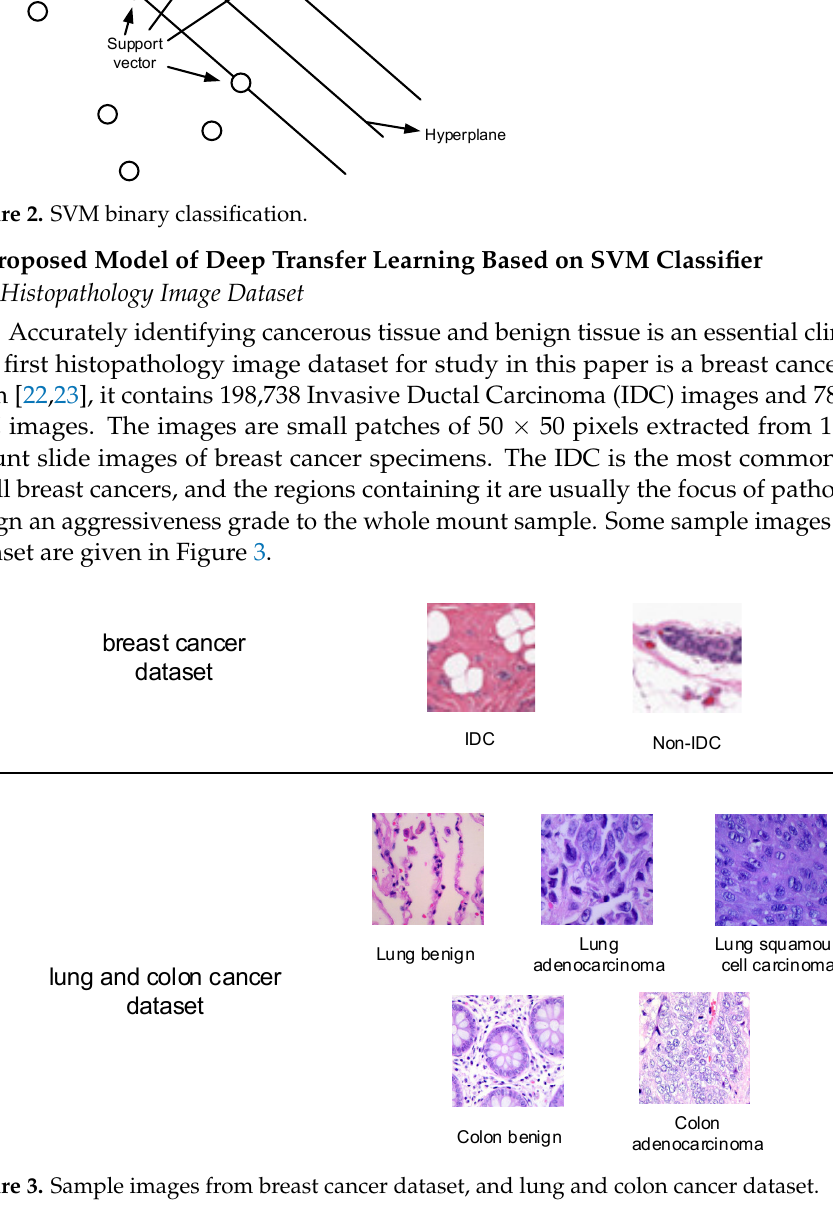
Figure 2. SVM binary classification.